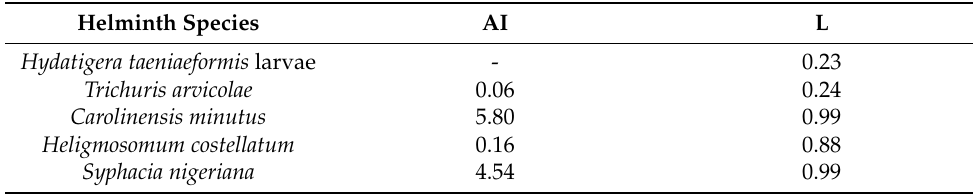
Table 8. Abundance Index (AI) and Lefkovitch Index (L) of the most prevalent helminth species of Microtus lusitanicus from Asturias.